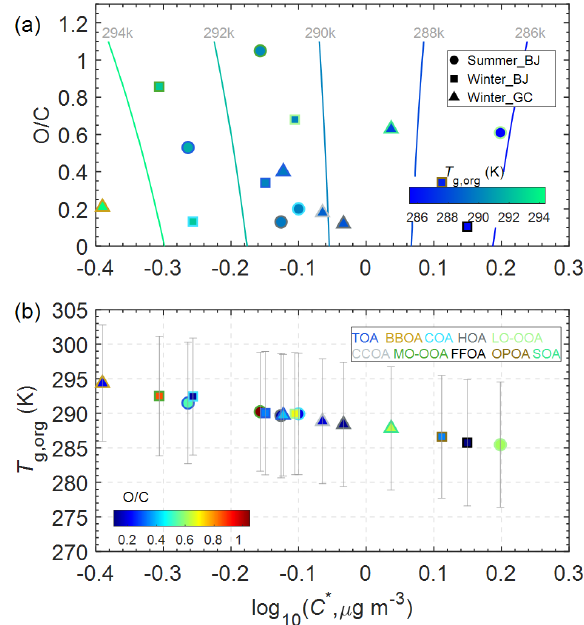
Figure 6. Predicted glass transition temperatures of organic aerosols under dry conditions ( T g , org ). The fill color of the mark- ers represents T g , org in (a) and O / C in (b) . The marker edge color indicates the OA components identified by